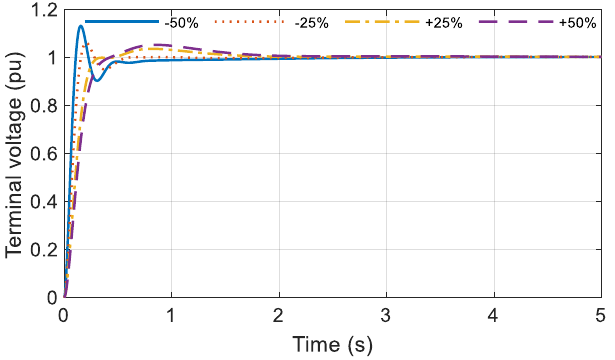
Figure 15. Step response under the variation of T G.